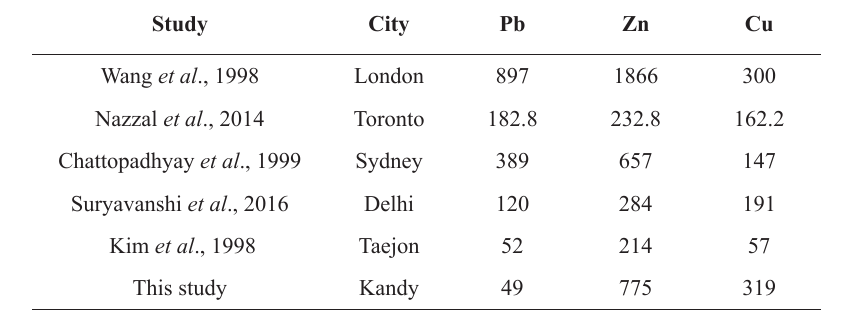
Table 6: Comparison of mean concentrations (mg kg -1 ) of heavy metals in dust in mega cities of the world.